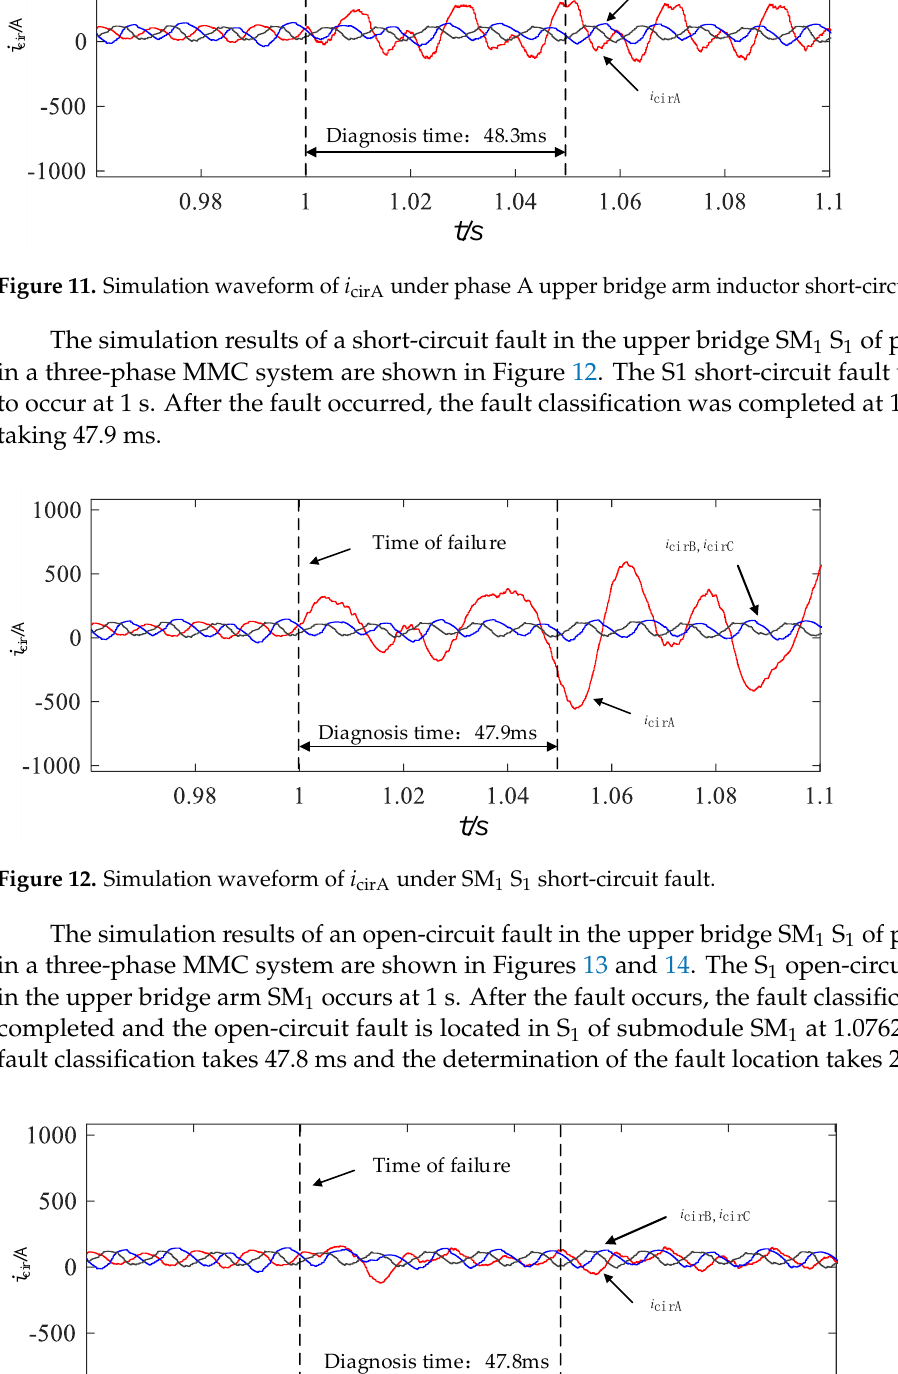
Figure 13. Simulation waveform of i cirA under SM 1 S 1 open-circuit fault.